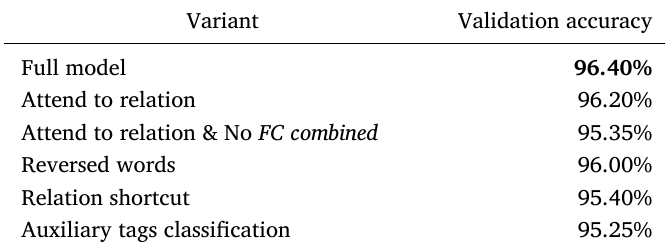
Table 5: Prediction accuracy of the proposed model trained with “attend to re- lation”, with and without the relation embedding fed to initial hidden state ( FC combined ), all words reversed, feeding the relation embedding using a shortcut to each step in the decoder RNN, and using auxiliary tags classification criterion, respectively. English validation